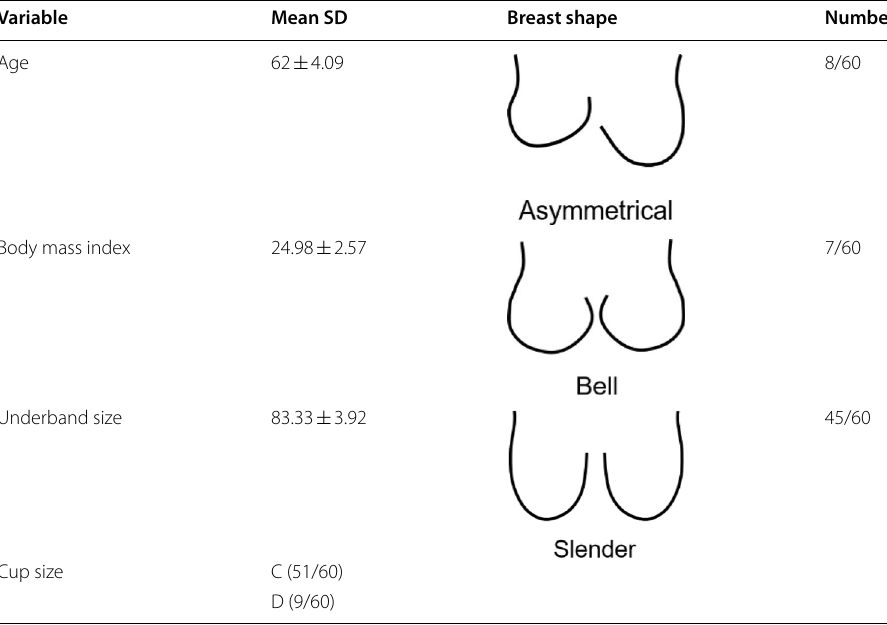
Table 1 Detailed body profile of